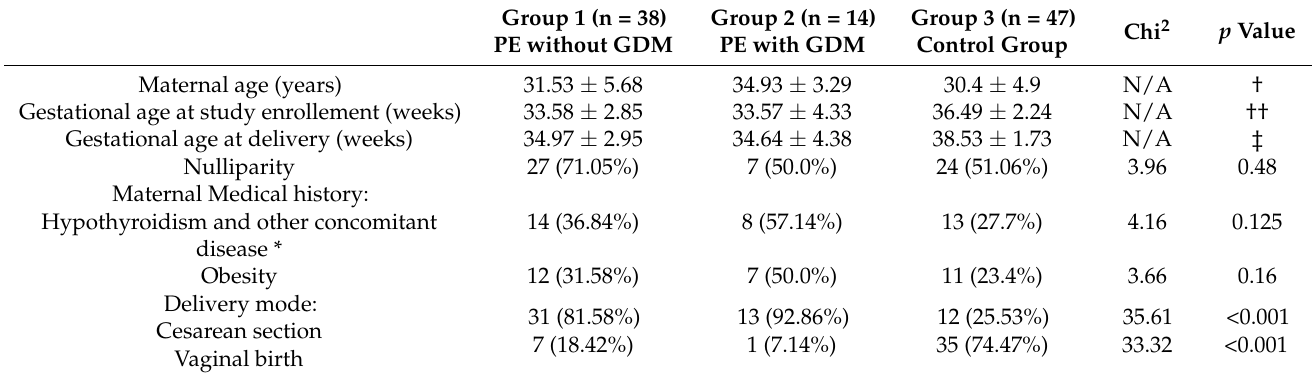
Table 1. Demographic and clinical characteristic of study